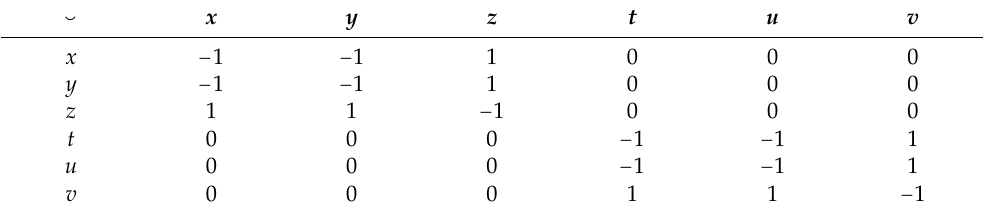
Table A4. Cup product of the cocycles deduced from Figure A10.